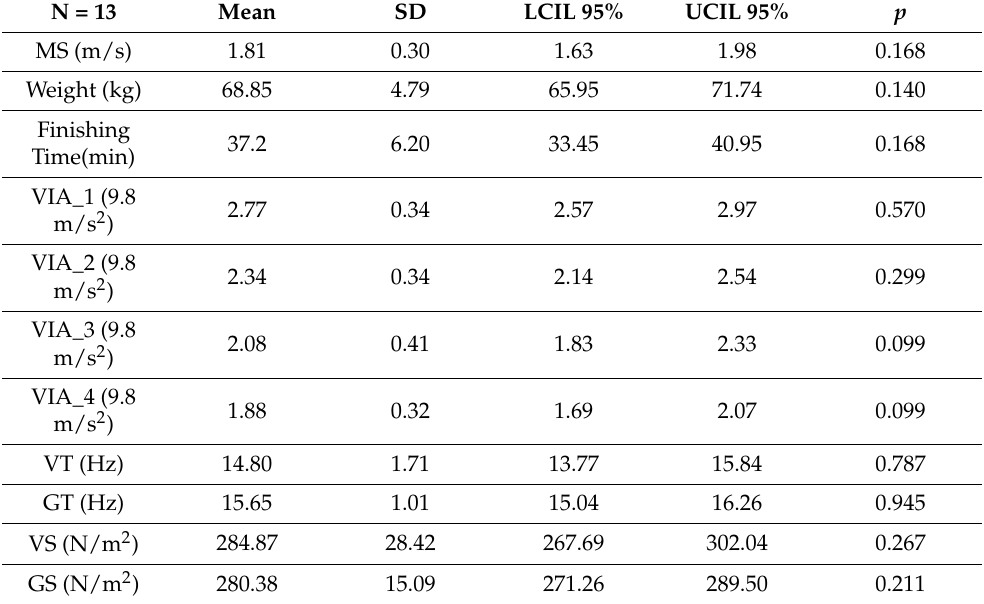
Table 2. Descriptive statistics of the participants. Standard deviation (SD), lower 95% confidence limit (LCIL95%); upper 95% confidence limit (UCIL95%), vertical impact acceleration (VIA),mean speed (MS), finishing time (min), gastrocnemius stiffness (GS), gastrocnemius tone (GT), vastus lateralis stiffness (VS), vastus lateralis tone (VT).